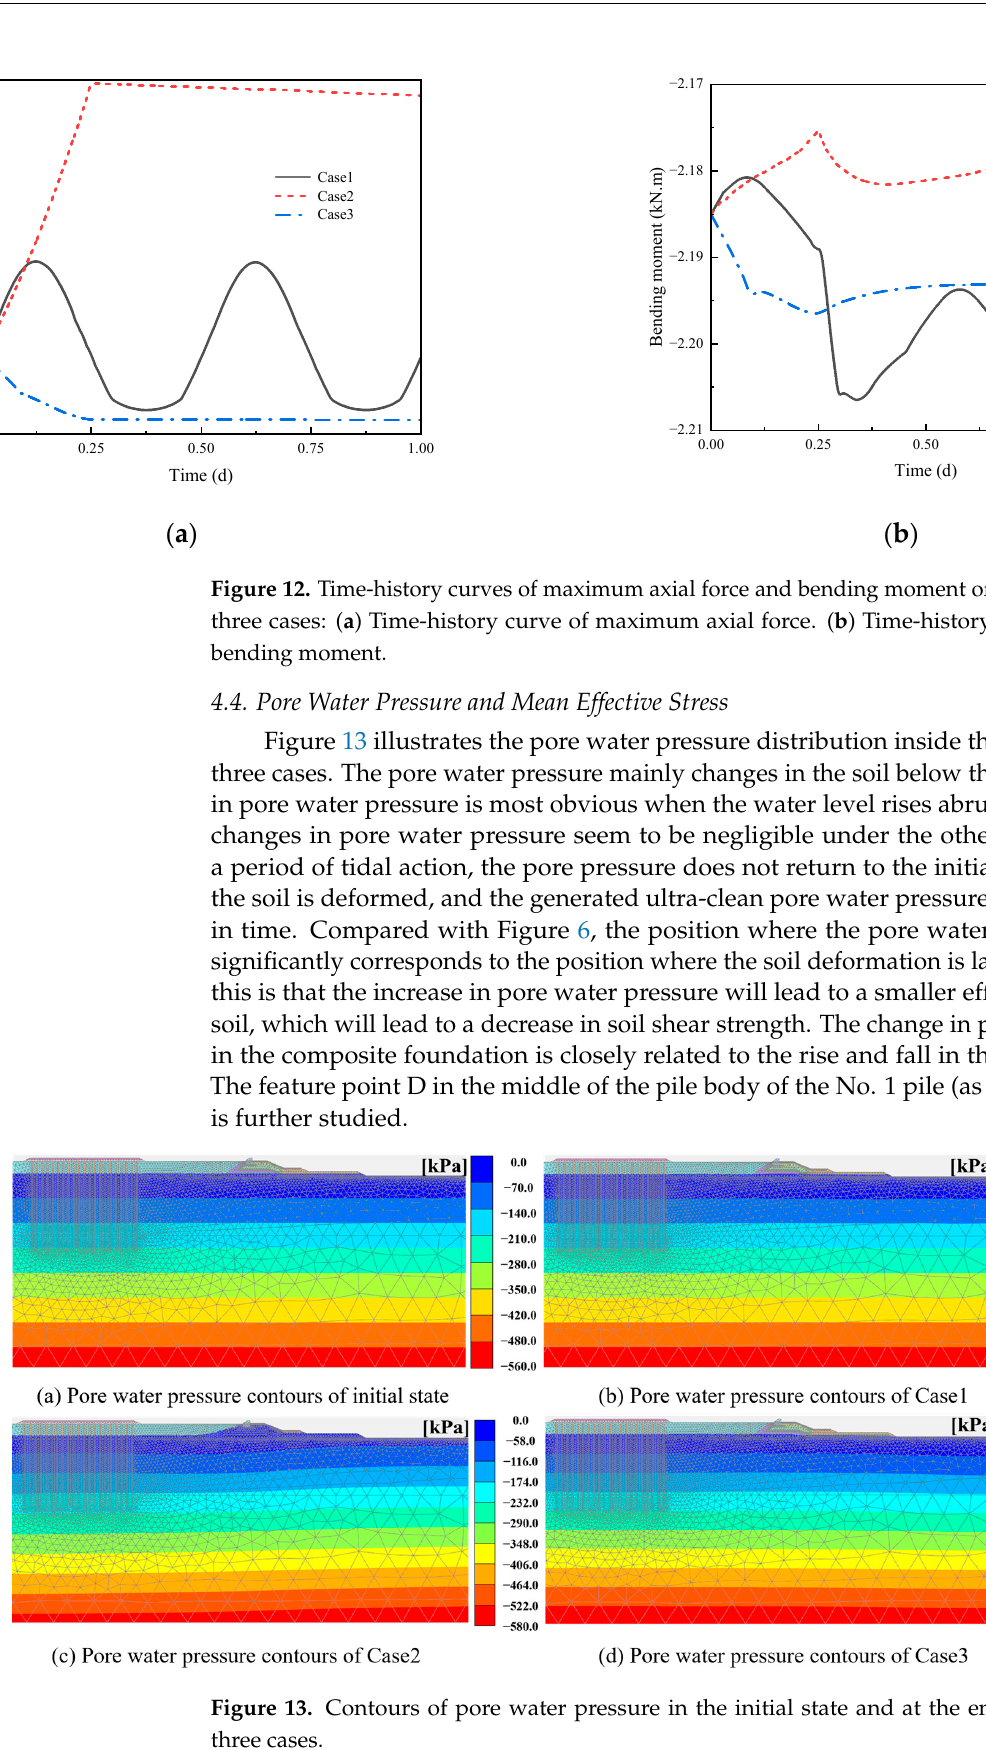
( b ) Figure 14. Fluctuation at feature point D under three cases:( a ) Pore water pressure fluctuation. ( b ) Average effective stress fluctuation. Figure 14b illustrates the evolution of the average effective stress of feature point D with time under the three cases. The average effective stress at point D in tidal action is roughly in the form of simple harmonics. The average effective stress at point D decreases at high tide and increases at low tide. The change period and law of the average effective stress and tidal action tend to be consistent, and there is also a certain hysteresis effect. The average effective stress decreases when the water level rises sharply, and the water level remains extremely high in the subsequent stage while the average effective stress changes little during this period. The average effective stress increases when the water level drops sharply and the water level remains extremely low in the subsequent stage. The average effective stress hardly changes during this period. Comparing Figure 13a,b, the change trend in the average effective stress corresponds to the change trend in the pore water pressure; the two show a trend of ebb and flow. Additionally, the shear strength of the composite foundation in case 2 is the lowest among the three cases, which is the most unfavorable working condition, since the average effective stress is directly related to the shear strength. This also corresponds to the maximum deformation of the pile body in the case of a sudden rise in the water level mentioned above. 0.0